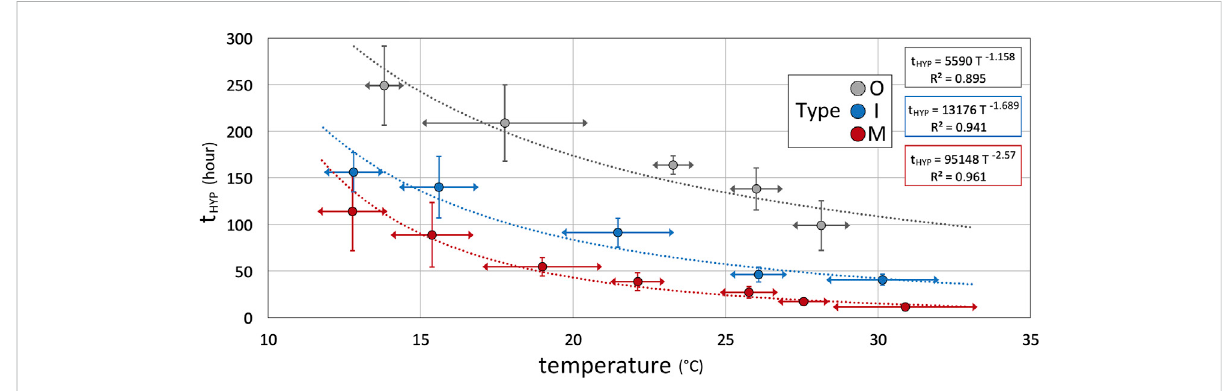
FIGURE 9 Plot of the relationship between temperature and t HYP for the three types of sites. Dots represent mean values of t HYP in the selected T range, highlighted by horizontal arrows; vertical segments indicate the respective t HYP standard